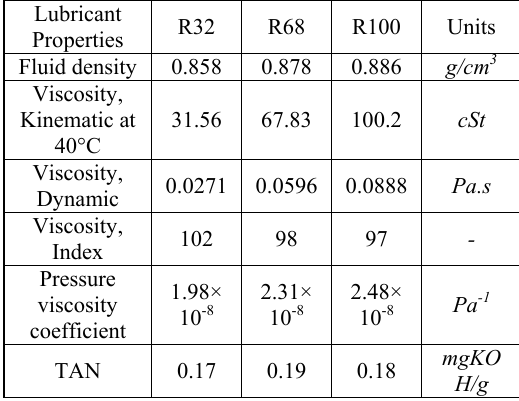
Table 2. Physical properties of the